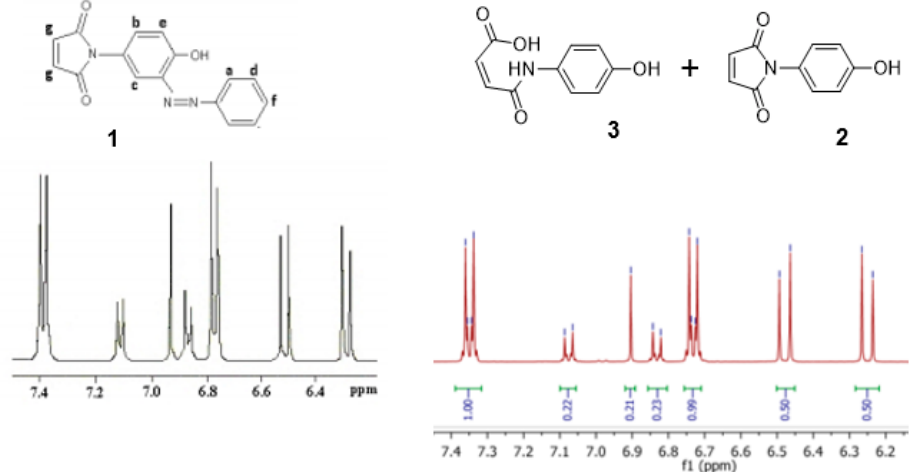
Figure 8. The remarkable similarity between the published 1 H-NMR spectrum [1] for ( 1 ) and our 1 H-NMR spectrum for the mixture of ( 2 ) and ( 3 ).